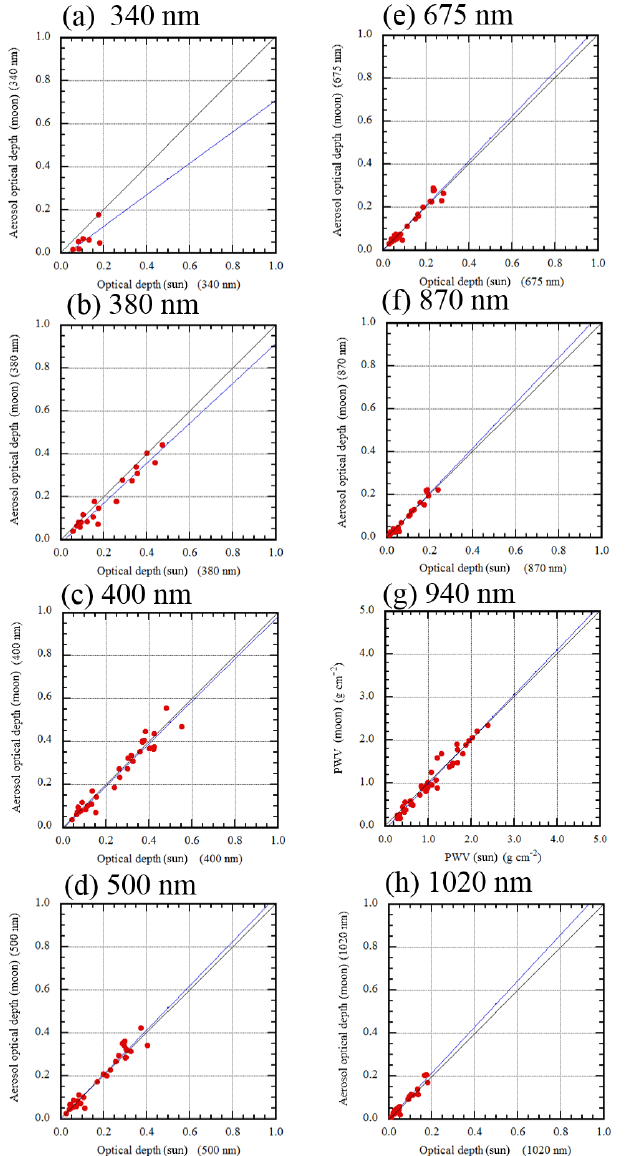
Figure 15. Scatter plot of AERONET and POM-02 aerosol op- tical depth (precipitable water vapor). Daytime (nighttime) mea- surements are indicated by a red (blue) symbol: (a) 340nm